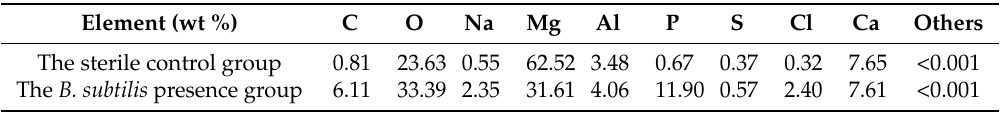
Figure 1. SEM images of AZ31B magnesium alloy specimens in control group ( A ) and B. subtilis presence group ( B ) at 48 h. (high voltage: 20 kV). Table 2. Elemental compositions (wt %) of the surface of AZ31B magnesium alloy specimens in the control group and B. subtilis presence group.